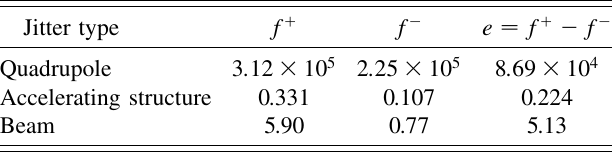
TABLE V. Emittance growth scaling factors for quadrupole, accelerating structure, and injected beam jitter, respectively. All values are given in nm =(cid:3) m 2